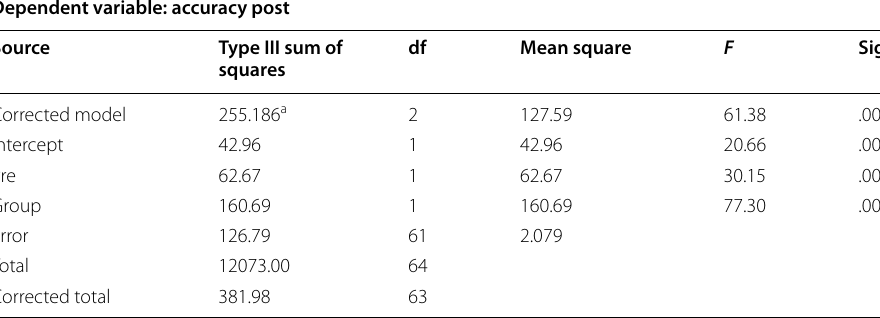
Table 2 Writing accuracy inferential